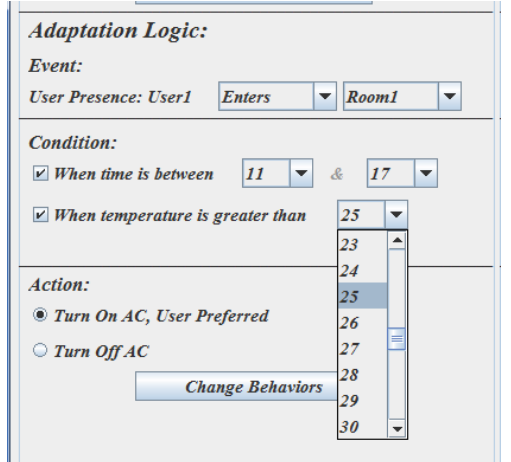
Figure 3. Adaptation Logic Modification in Smart AC